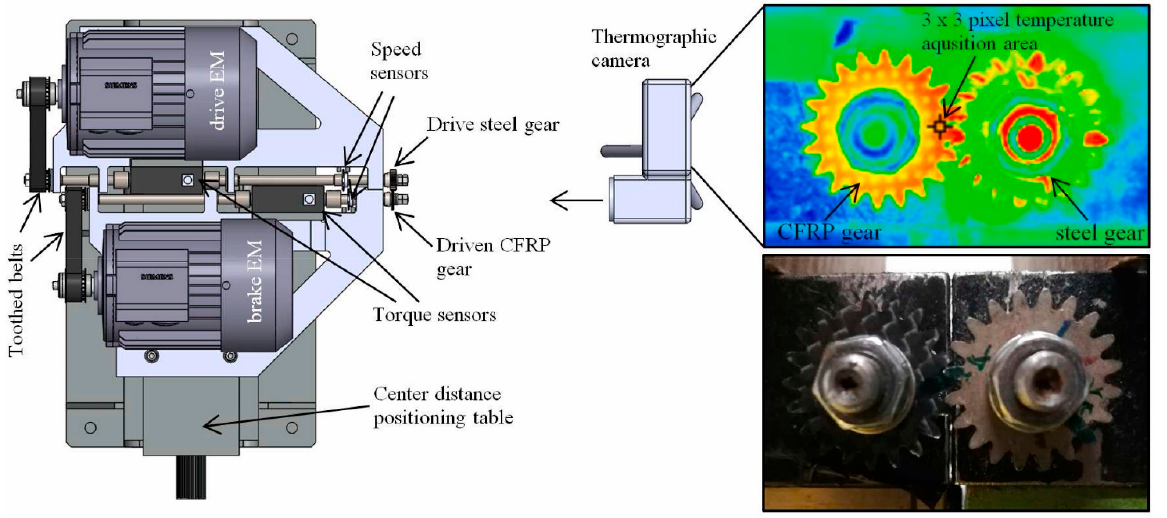
Figure 7. Model, illustration and thermogram illustrating the occurrence of the self-heating effect during the operation of a CFRP composite gear [47].